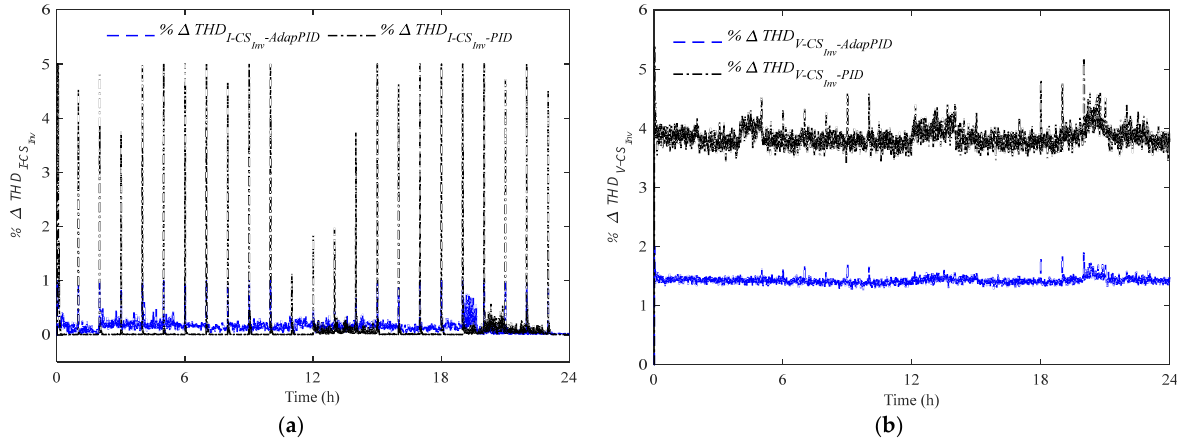
Figure 8. % change in CS converter ( a ) Current THDs ( b ) Voltage THDs .